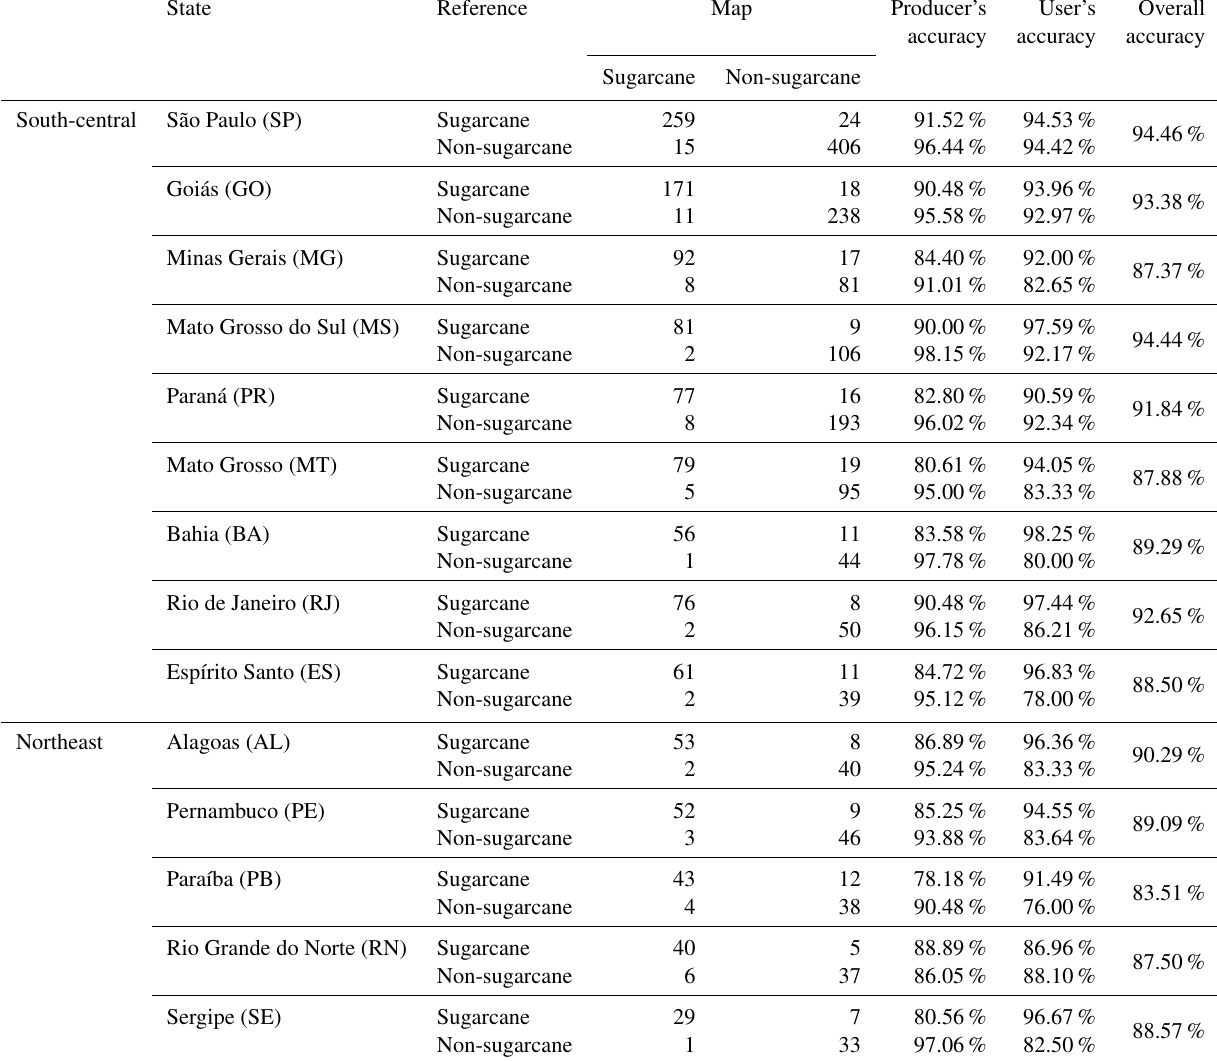
Table 1. Confusion matrix of the sugarcane harvest map for the 14 states in Brazil in